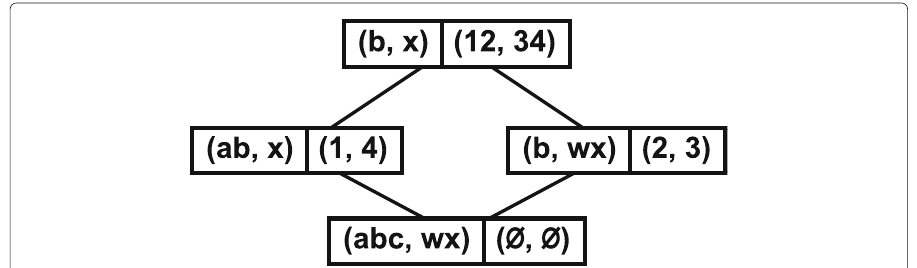
Fig. 11 The abstract bi-concept lattice of Example 6. Each node represents a closed bi-pattern (on the left) together with the associated extent (on the